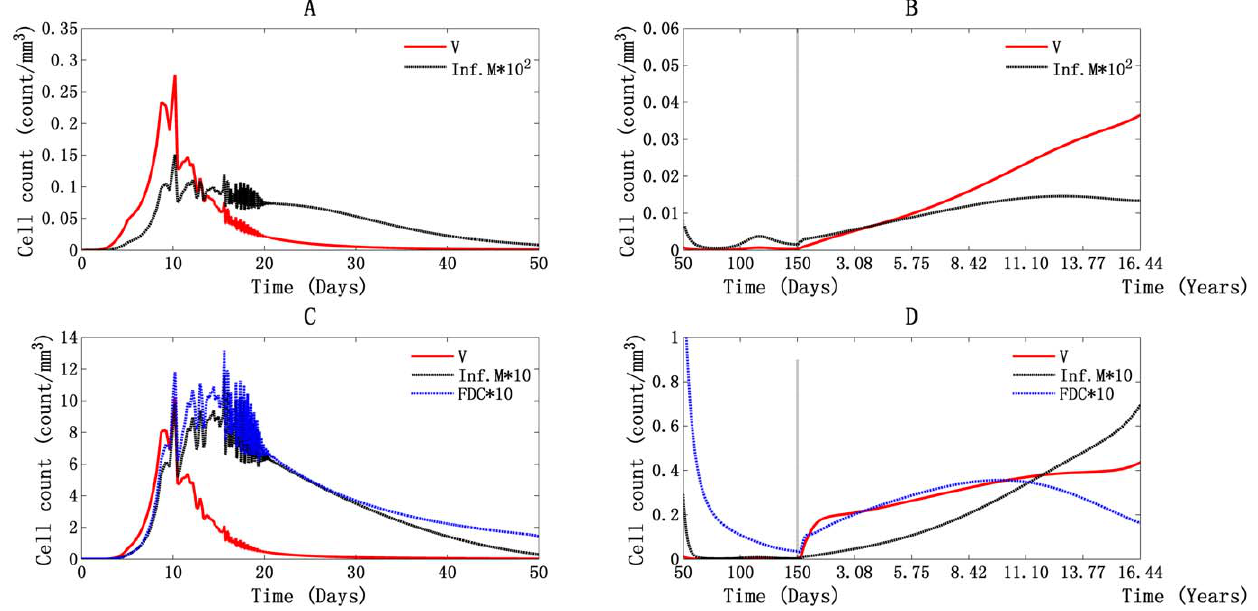
Figure 8. Illustration of T4 cell infection in PB and LNs. T4 cell infection caused by free virus, infected macrophages, and FDC in PB (A and B) and LNs (C and D), during the first 50 days (A and C) and from day 50 to day 6000 (B and